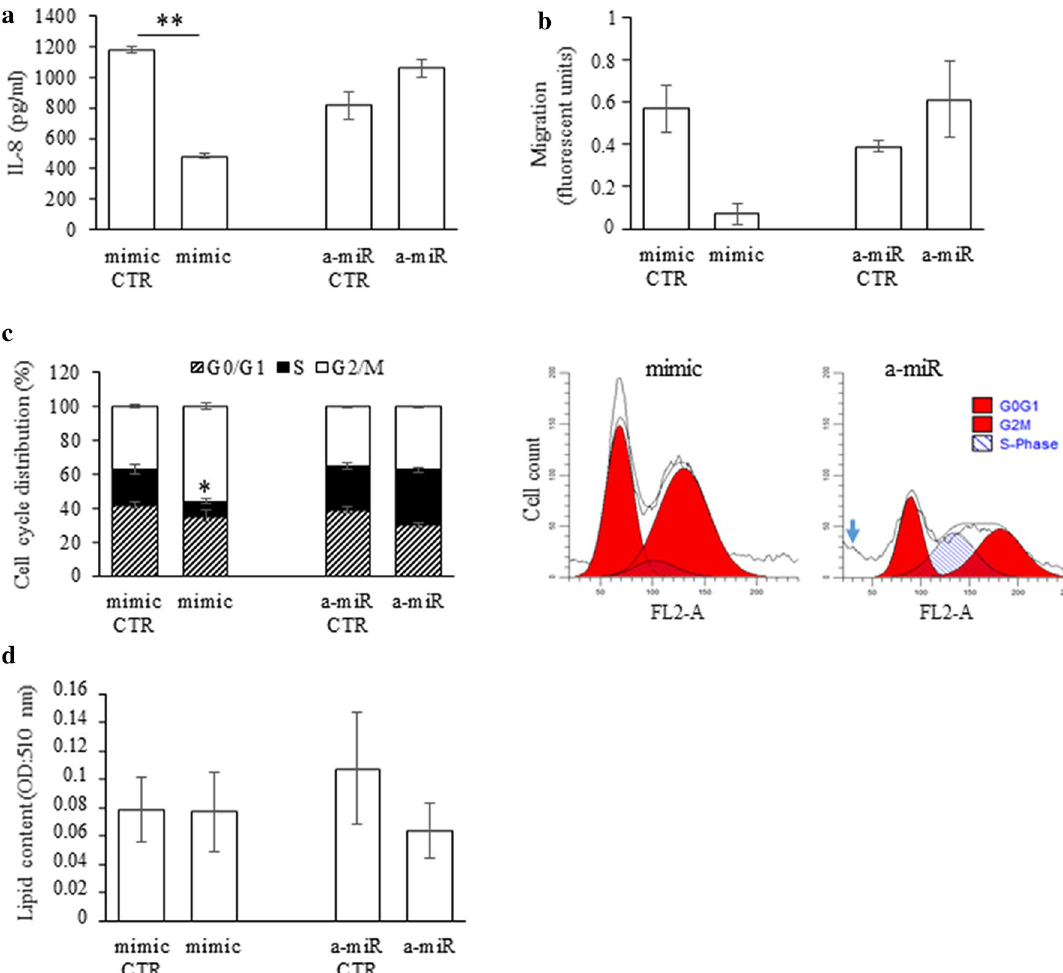
Figure 3. Characterization of the effects of miR-146a on sebocyte functions. SZ95 sebocytes were transfected with miR-146a mimic- (mimic), miR-146a inhibitor (a-miR) or their relevant negative control (mimic CTR for mimic; a-miR CTR for inhibitor) sequences as described in “Methods”. ( a ) Transfection with miR-146a mimic caused a decrease (481.3 ± 32.7 versus control 1178.4 ± 57.2 pg/ml, p-value: 0.002), while with miR-146a inhibitor caused an increase (1056.1 ± 36 versus 813.5 ± 55.5 pg/ml) in the secreted IL-8 levels when compared to transfection with control sequences as measured from the supernatants of SZ95 sebocytes by ELISA. ( b ) Migration assay revealed that monocytes migrated less towards mimic and more towards inhibitor transfected sebocyte supernatants when compared to negative controls. Graphs show the fluorescence intensity of migrated cells as described in “Methods”. ( c ) Measurement of G0, G1, S, G2, M cell cycle phases and apoptosis in SZ95 sebocytes treated with miR-146a mimic, miR-146a inhibitor (a-miR) or their negative controls (mimic CTR for mimic; a-miR CTR for inhibitor) for 72 h. Graphs show the percentage of cells in each phase based on the DNA content analysis measured by flow cytometer. Cell populations treated with mimic sequence showed a significantly lower number of cells in S phase (8.69% versus 21.51% of cells, p-value: 0.05) and larger in G2/M phase (56.02% versus 36.78% of the cells) compared to samples treated with negative control sequences. In the sebocyte cultures treated with inhibitor, more cells were found in S phase (32.62% versus control 25.95% of cells) and less in G0/G1 phase (30% versus 38.93%) when compared to samples treated with negative control sequences. Note the sub-G0/G1 peak in the histogram, representing apoptotic cells (blue arrow). Total cell count: 20.000 for each sample. ( d ) Oil Red O staining of SZ95 sebocytes. Treatment with miR-146a mimic or with miR-146a inhibitor sequence caused no significant change in the lipid content. Graphs show the mean optical density of samples. FU: fluorescence unit. All experiments were carried out in biological triplicates. P-values were calculated using non-parametric Mann–Whitney test, p-values < 0.05 were considered as statistically